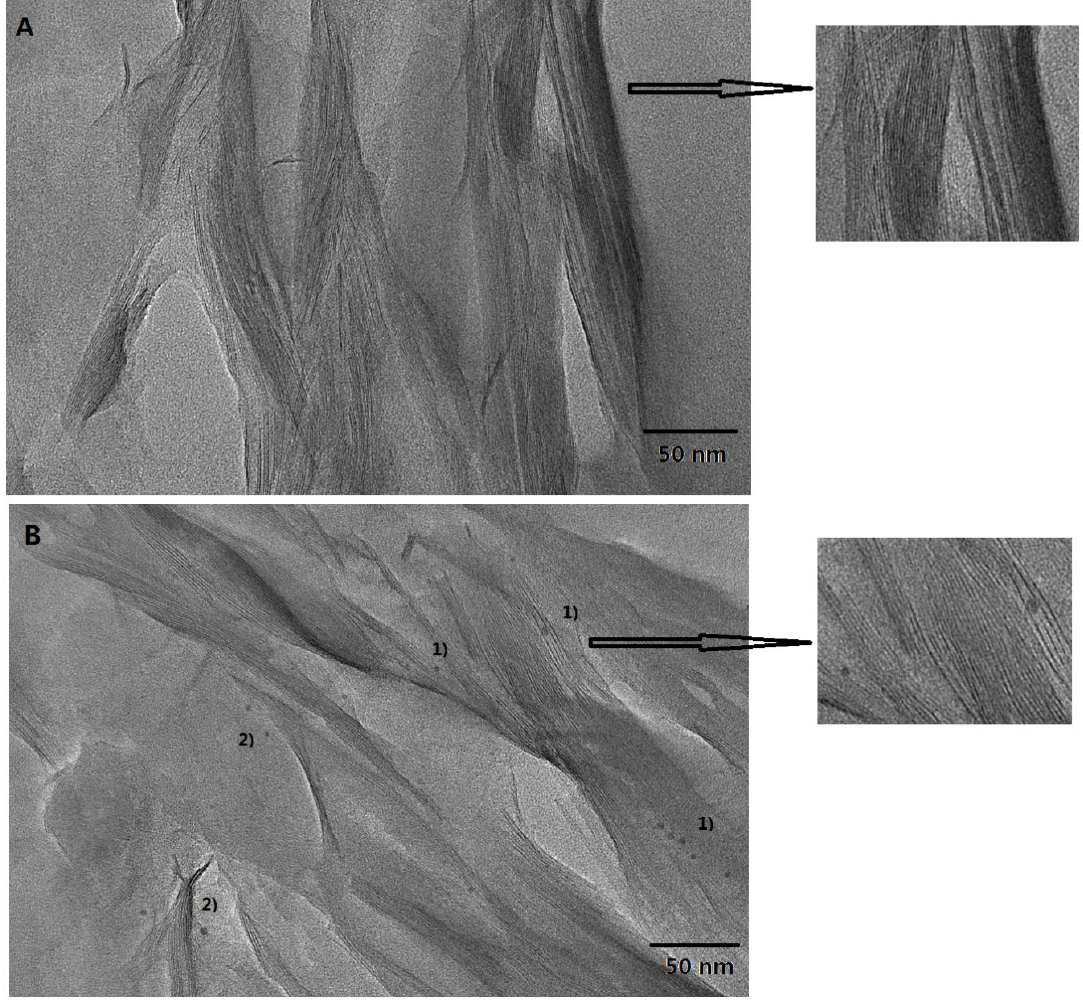
Figure 3. HR-TEM results of the MMT / PEO (80 / 20) hybrid ( A ) and Pd 0 @MMT / PEO (0.2 / 80 / 20) catalytic composite ( B ). The insert figures are the enlarged view of the local regions in the HR-TEM photos.